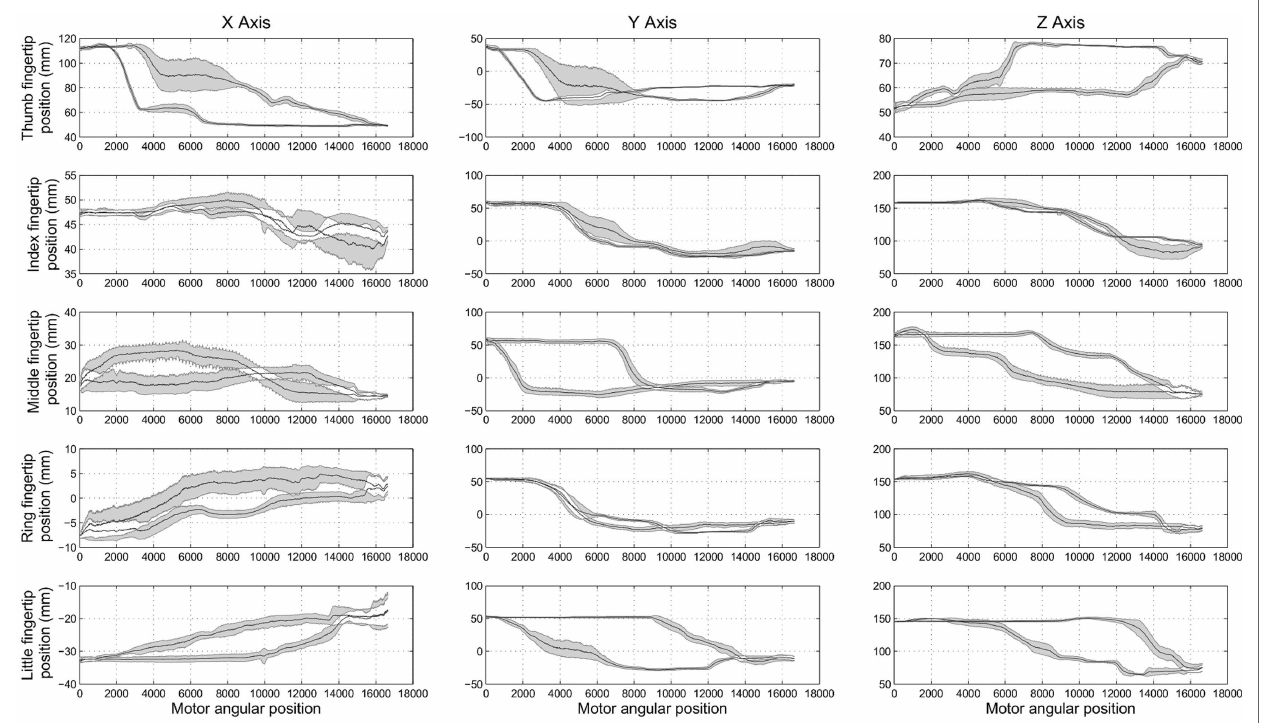
FIGURE 6 | Experiment 1 : spatial position of SH-P fingertips (expressed in the spatial coordinates x, y, and z) w.r.t. the angular position of the motor . Black traces in the subplots are the mean closing and opening paths averaged across trials, and gray areas denote the SD of the mean